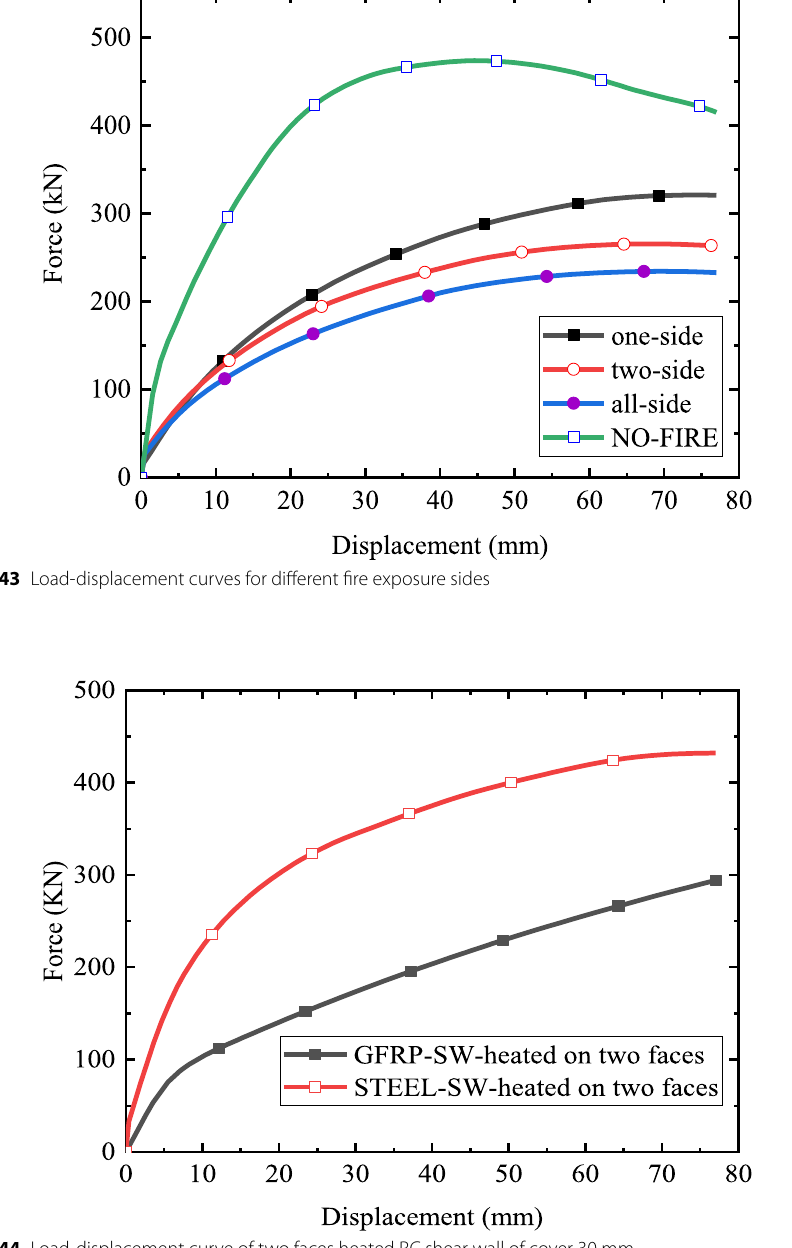
Crack distribution (damages) The damages recorded on the fire exposed RC shear walls subjected to combined action of axial and monotonic lateral loads were different for different drift ratios. In this study, three drift ratios (i.e., 1%, 2%, and 3%) were used to study crack patterns of the shear wall for each parameter. Figure 46a–i shows crack distributions on the shear wall for concrete cover thicknesses of 20 mm, 25 mm, and 30 mm respectively for different drift ratios. Crack distributions on the shear wall for the parameter duration of fire exposure were